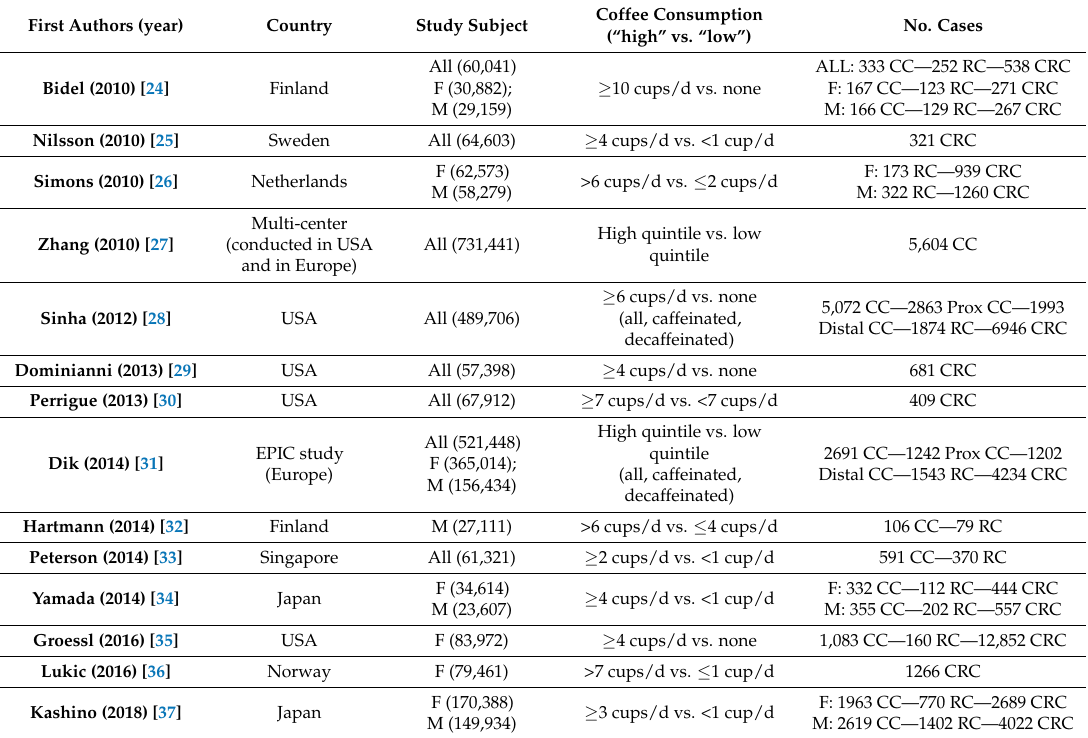
Risk ratio (RR) and 95% CI for all meta-analyses carried out. Values in bold are statistically significant. Tumor and Geographic Provenience of the Studies